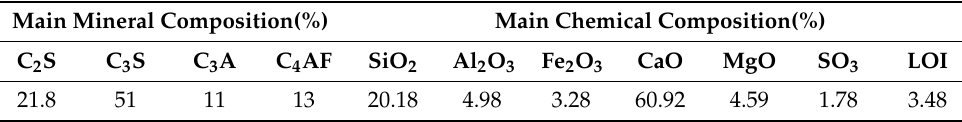
Table 2. Main components of cement (mass fraction).